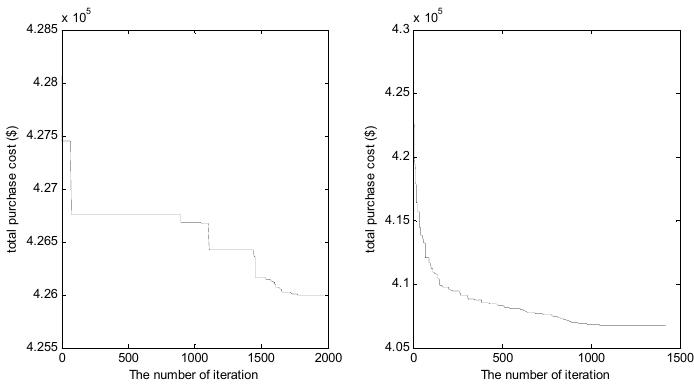
Figure 8. Convergence curves of the two algorithms (QPSO left IQPSO right )